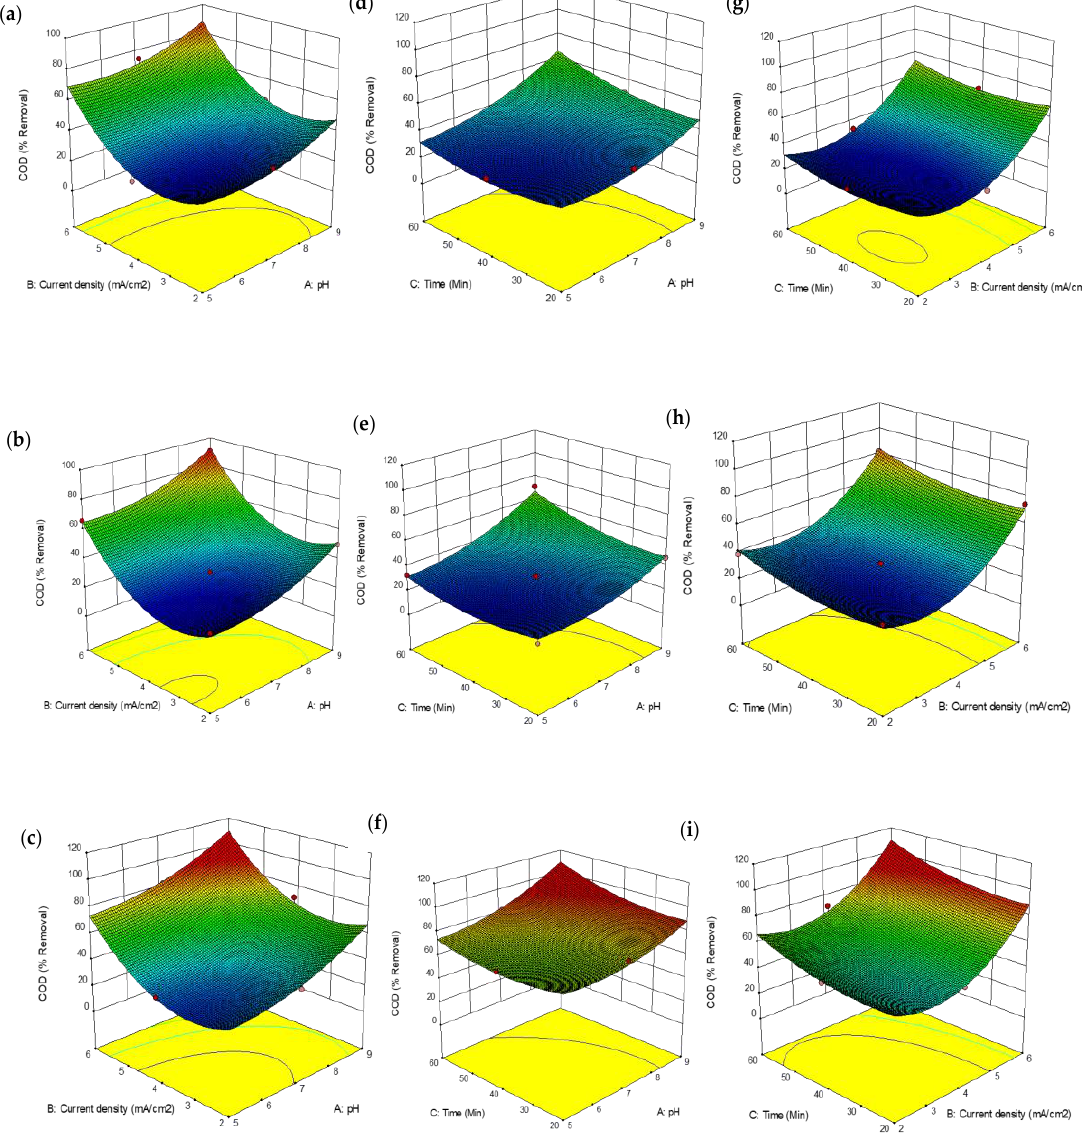
Figure 4. Three-dimensional surfaces for COD reduction effectiveness: First column current density vs. initial pH at an EC time of 20 min ( a ), 40 min ( b ) and 60 min ( c ). Second column EC time vs. initial pH at current density 2 mA/cm 2 ( d ), 4 mA/cm 2 ( e ) and 6 mA/cm 2 ( f ). Third column EC time vs. current density at initial pH 5 ( g ), pH 7 ( h ) and pH 9 ( i ).